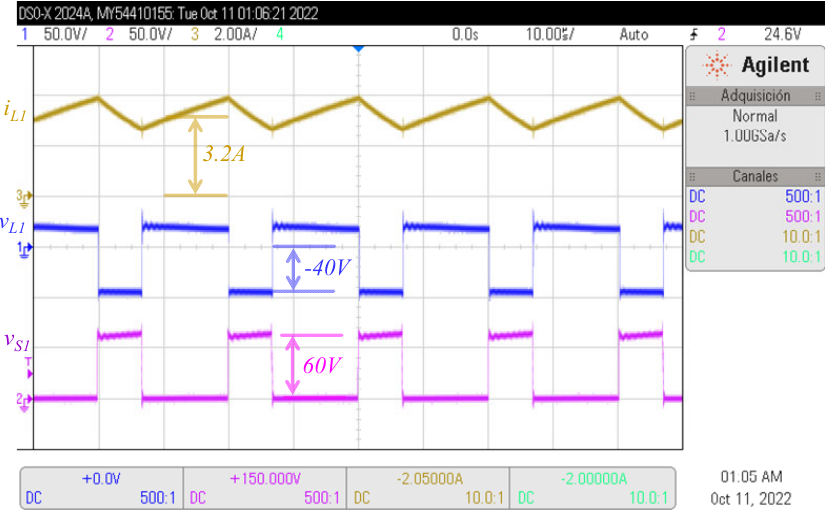
Figure 17. Current and voltage in L 1 , as well as the voltage across switch s 1 .